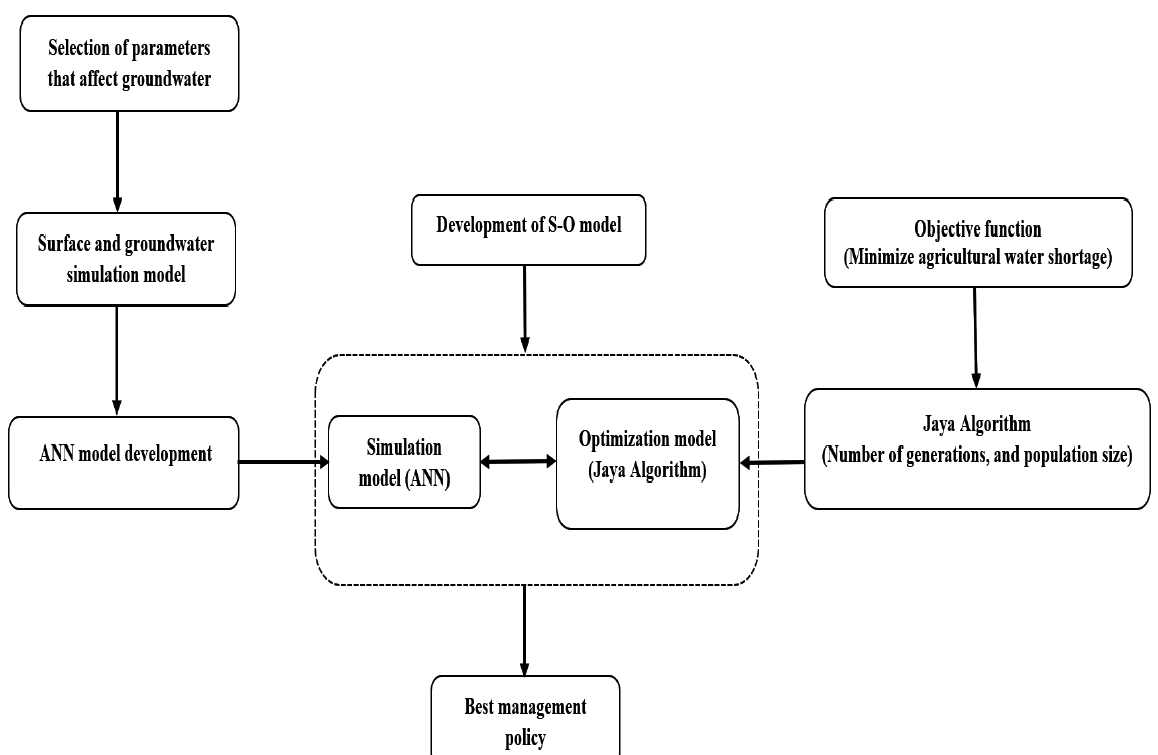
Figure 7. Schematic representation of the linked S-O model.